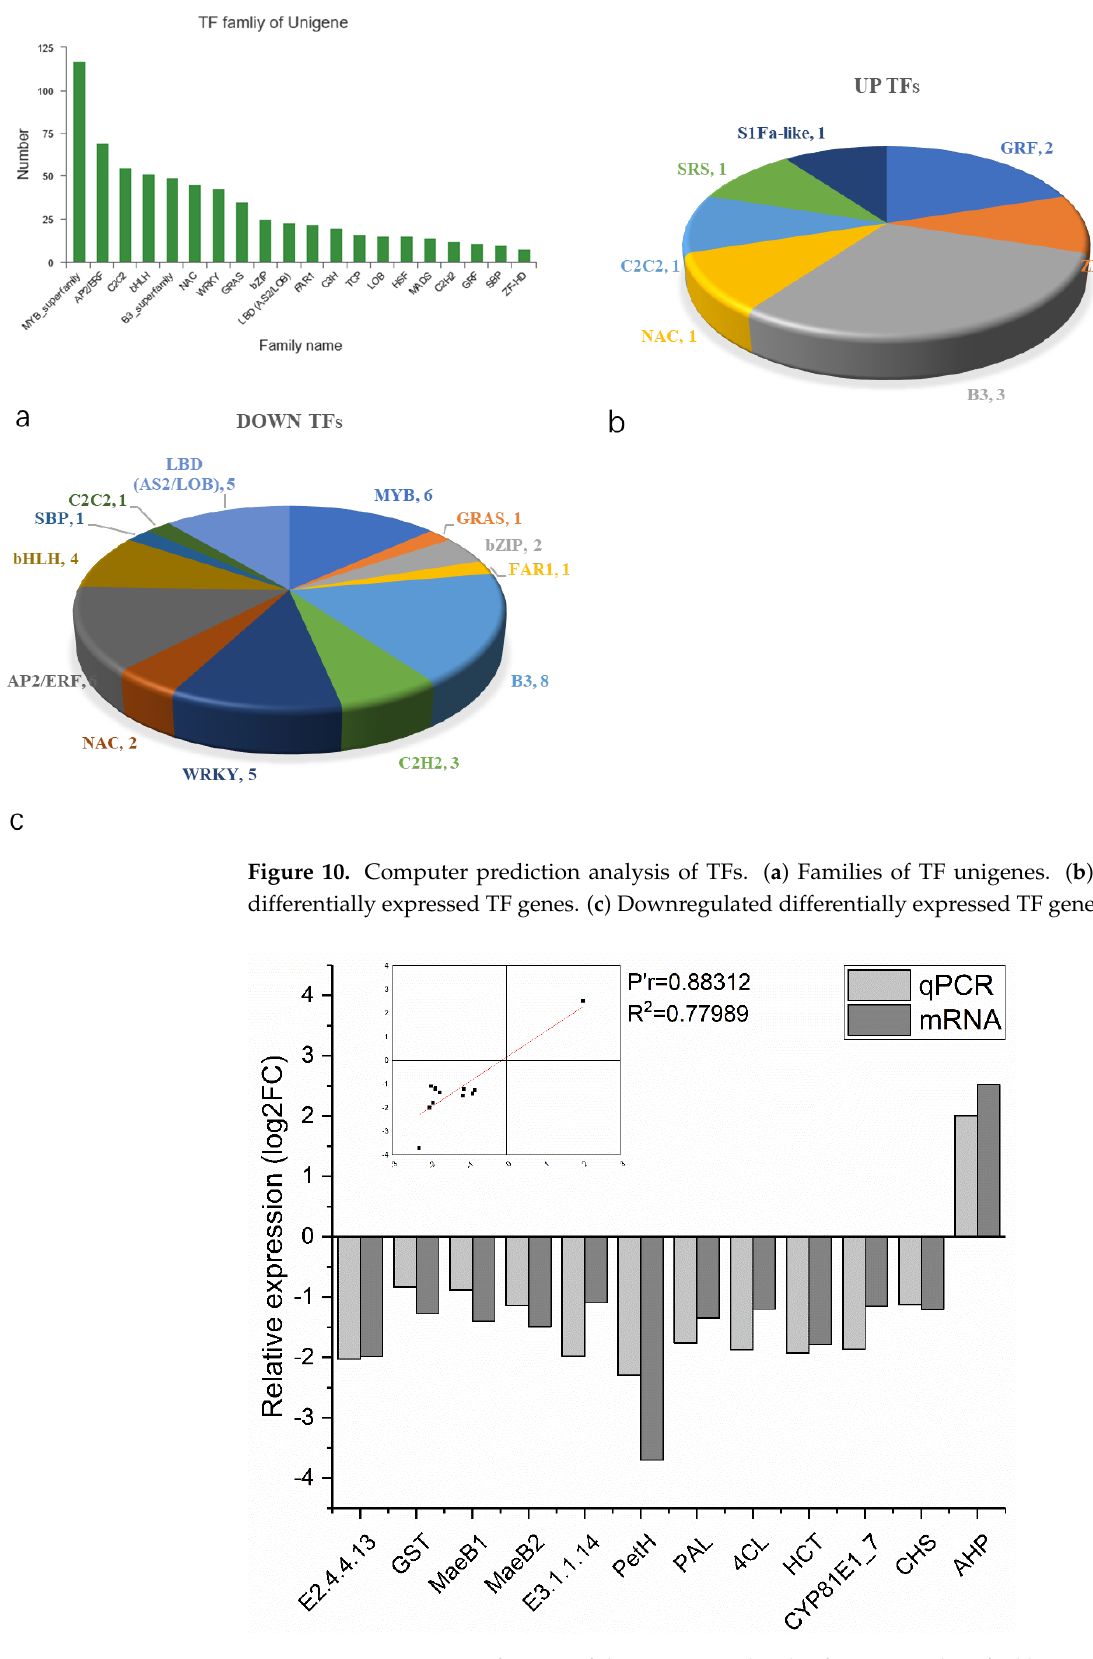
Figure 11. RT – qPCR verification of the expression levels of 12 DEGs identified by RNA –